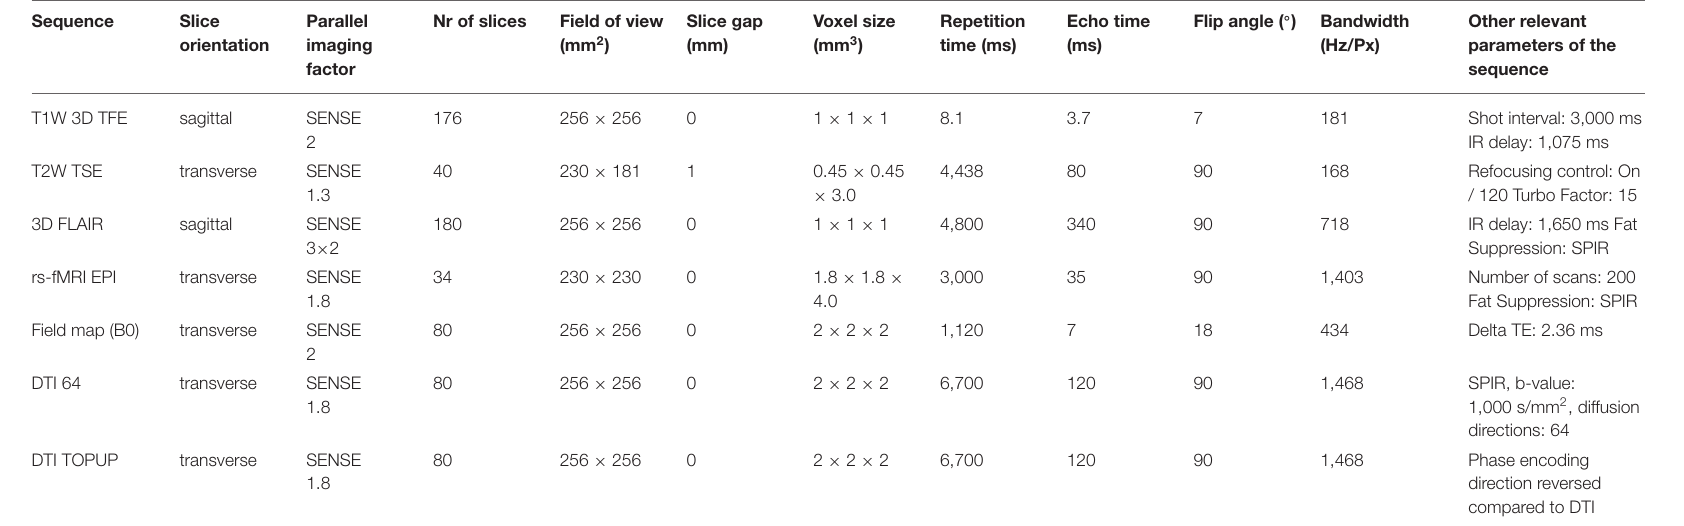
DTI, Diffusion tensor imaging; Flair, Fluid-Attenuated Inversion Recovery; rs-fMRI, Resting-state Functional Magnetic Resonance Imaging; TFE, Turbo Field Echo; TSE, Turbo Spin